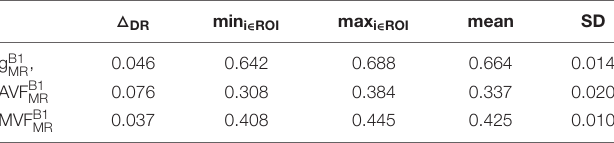
TABLE 2 | Summary statistics of g B1 MR , AVF B1 MR , and MVF B1 MR .